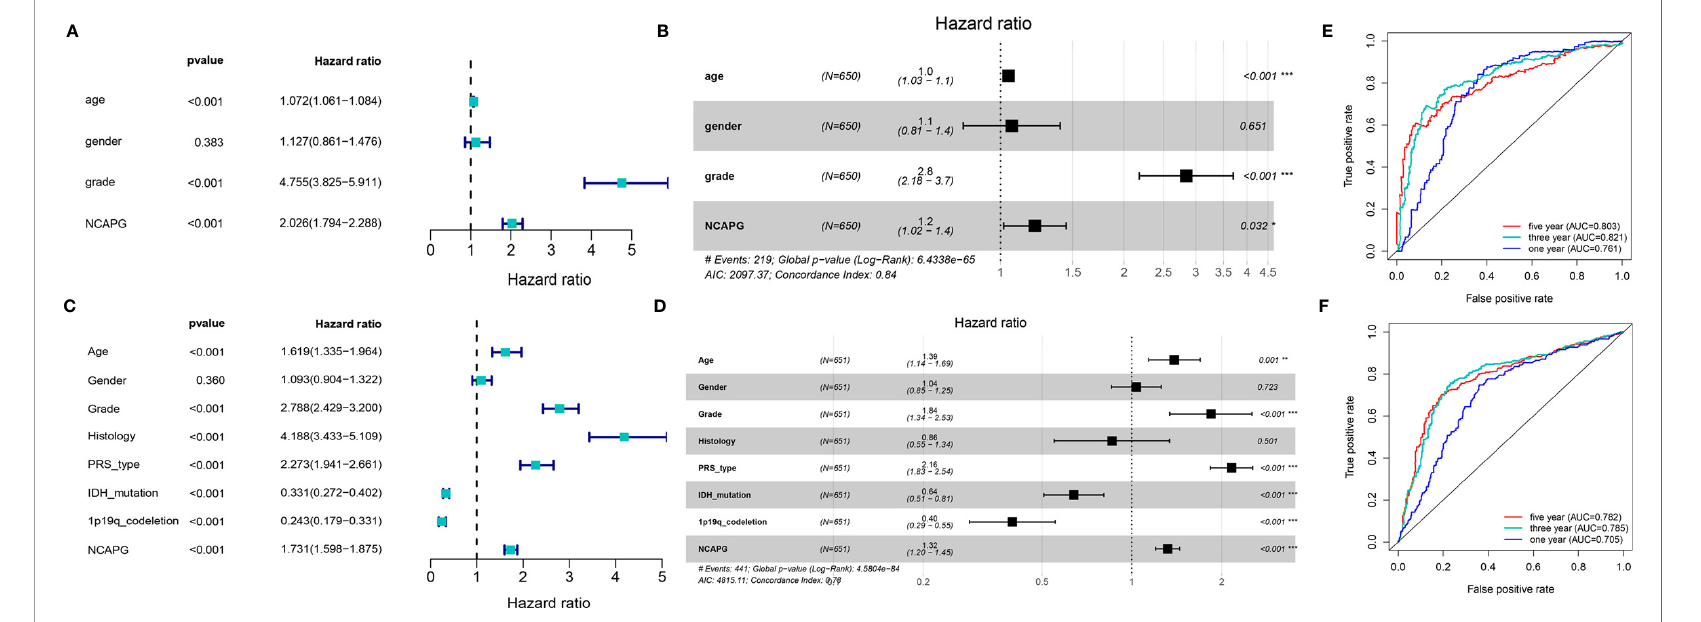
FIGURE 3 | Construction and veri fi cation of single gene diagnostic model. (A, B) Univariate and multivariate COX analysis of NCAPG using the TCGA database. (C) The predictive capacity of the risk score for the 1- year, 3- year, and 5- year survival rates of patients in TCGA; AUC, area under the curve. (D, E) Univariate and multivariate COX analysis of NCAPG using the CGGA database. (F) The predictive capacity of the risk score for the 1- year, 3- year, and 5- year survival rates of patients in CGGA; AUC, area under the curve. (*P < 0.05, **P < 0.01, ***P <